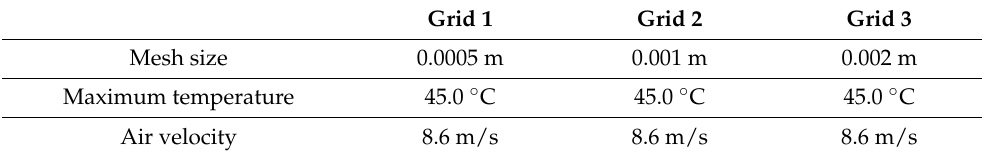
Table 2. Grid density independence verification results.